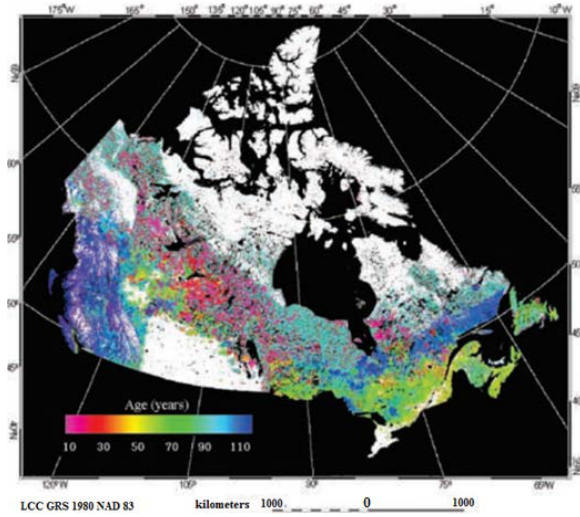
Figure 8. Distribution map of forest age (1973 to 1998) The LISA map SOC distribution in the Subarctic eco-region is shown in Figure 9. Soil samples with higher organic carbon stock (highlighted by a red ellipse) are mainly clustered in Peel Plateau and Peel Plain region. Soils in this area are usually cold and wet (likely affected by snowmelt), and thus accumulate a considerable amount of organic matter, as highlighted by a HH cluster. Another small HH cluster occurs along the east coast, mainly located in Melville Lake estuary (Newfoundland and Labrador). This area is also considered to be an area of interest where ongoing soil organic matter research is being undertaken (e.g., the Earth Science Laboratory of Memorial University). A LL cluster was also observed in central Quebec, where there is little vegetation biomass. This may also play a role in influencing SOC distribution.